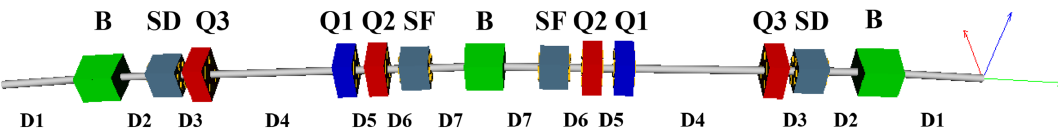
FIG. 4. The lattice structure of TBA design and the magnet layout. The green cuboids represent dipoles, the red ones and the blue ones represent focusing quadrupoles and defocusing quadrupoles, respectively, while the indigo blue ones represent sextupoles.